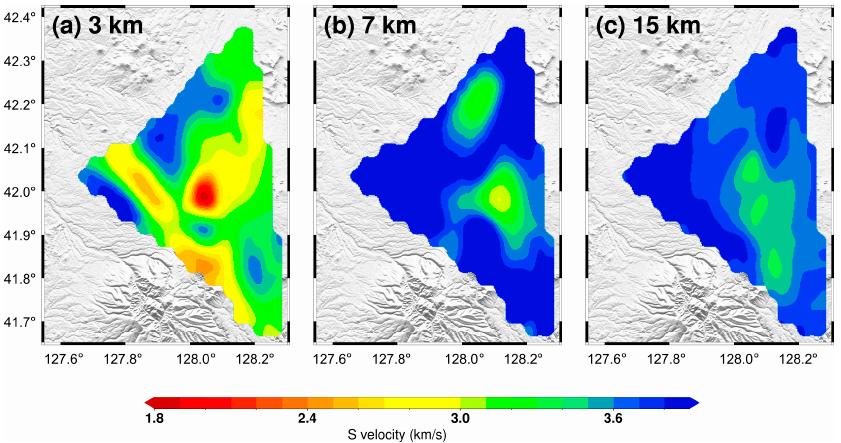
Figure A14. Combination of the interpolation and original results with 0.01° × 0.01° grid.